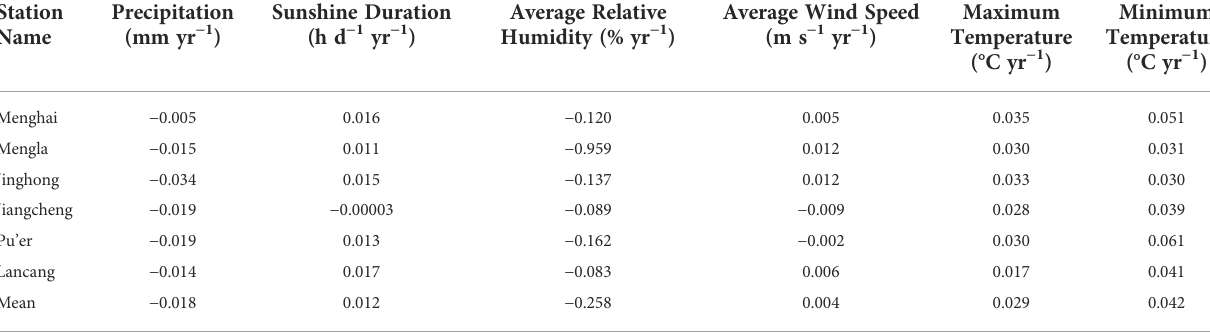
TABLE 3 Interannual variation trend of meteorological elements at each meteorological station.